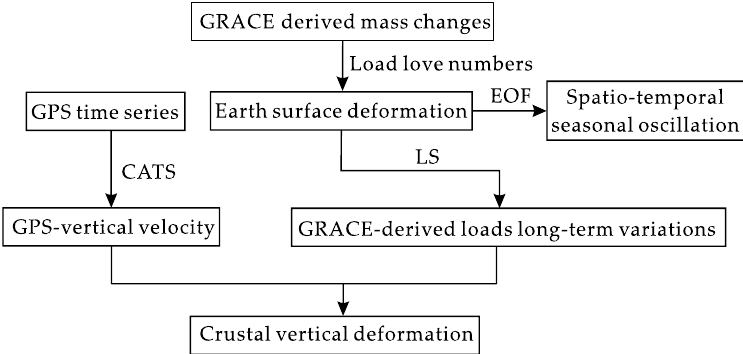
Figure 1. Five steps represent the brief procedures from GRACE, GPS to final crustal vertical deformation. EOF, Empirical Orthogonal Function; CATS, Create and Analyse Time Series software; LS, least squares.